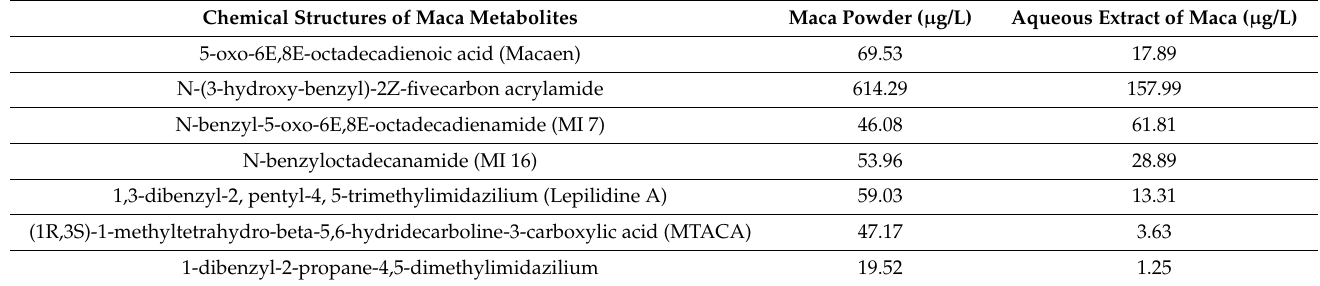
Table 1. Concentrations of Maca metabolites in Maca powder and aqueous extract of Maca. Chemical Structures of Maca